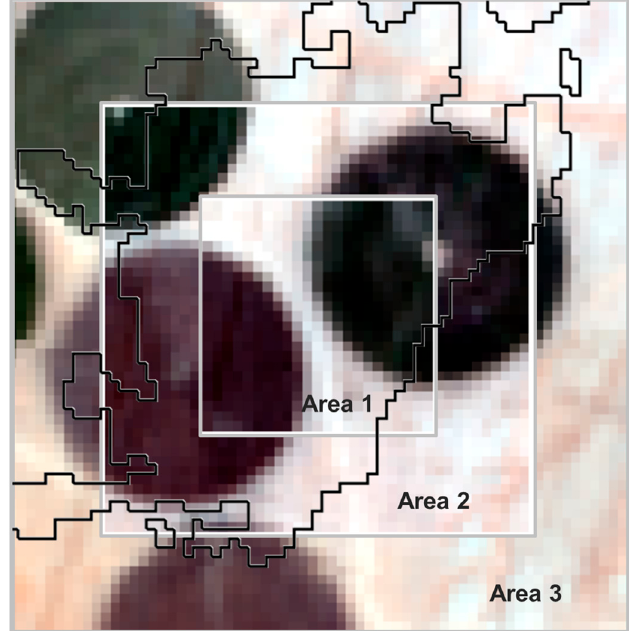
Figure 8. Artificial cloud superimposed over cloud-free areas, which is then used to assess the